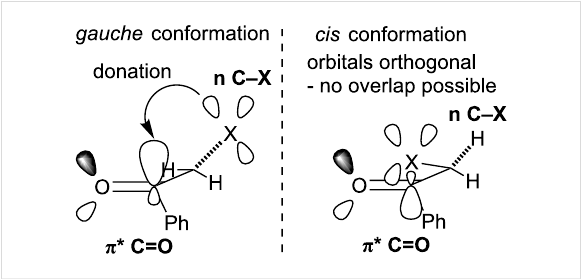
Figure 5: Orbital interactions in gauche - and cis -conformations of